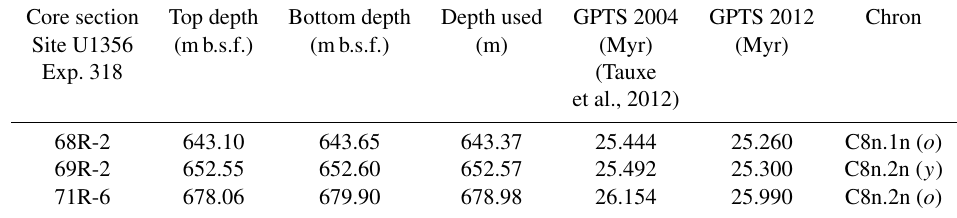
Table 1. Age model by Tauxe et al. (2012) and transformed ages to GPTS 2012. Core